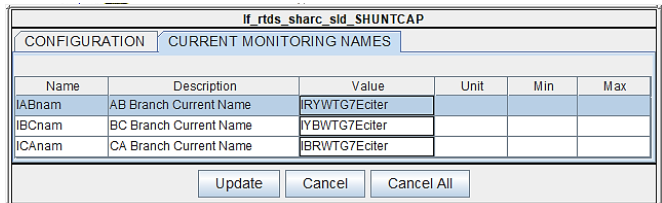
Figure 22. Excitation circuit control, monitoring, and calculation logic.